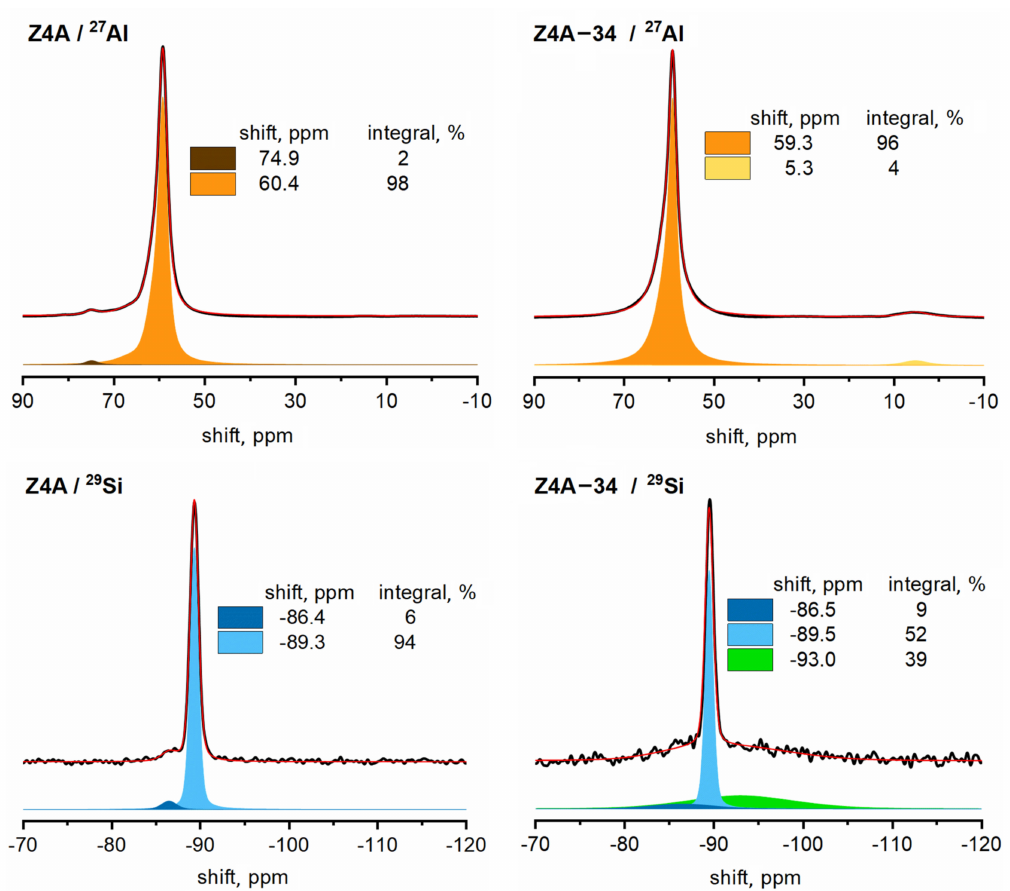
Figure 3. 27 Al and 29 Si MAS NMR spectra of Z4A and Z4A-34 (black lines = measured spectra, red lines = modeled spectra, color filled areas under the curve = individual contributions to the modeled